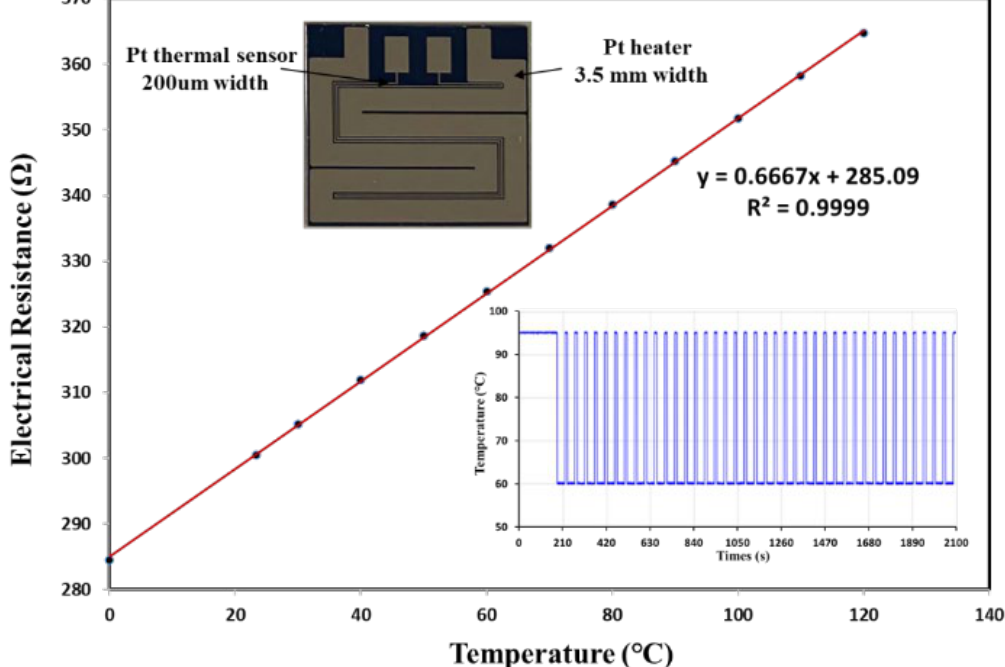
Figure 3. The relationship between Pt sensor resistance and temperature where the correlation coefficient ( r = 0.9999 ) and PCR temperature pattern of thermal cycling.